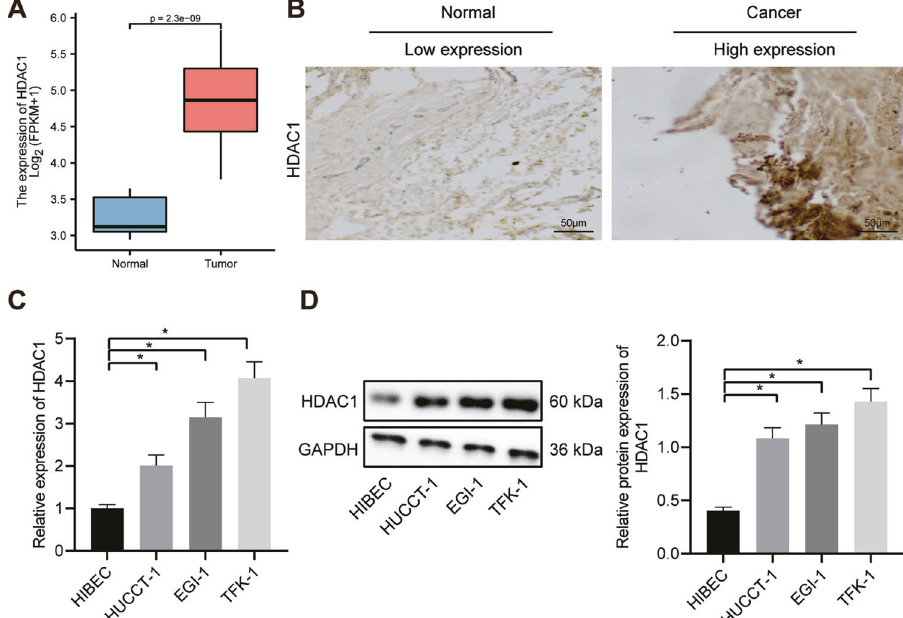
Fig. 1 HDAC1 is upregulated in CC clinical samples and cells. A TCGA database analysis of HDAC1 protein in CC tissues ( n = 36) and control tissues ( n = 9). B The immunohistochemical staining of HDAC1 protein in CC tissues ( n = 65) and normal bile duct tissues ( n = 35). C HDAC1 mRNA expression in TFK-1, HUCCT-1, EGI-1 and HIBEC cell lines determined by RT-qPCR. D, HDAC1 protein expression in TFK-1, HUCCT-1, EGI-1 and HIBEC cell lines measured by Western blot analysis. * p < 0.05. In panels ( A ) and ( B ), data were compared by unpaired t- test. In panels ( C ) and ( D ), data were compared by one-way ANOVA with Tukey ’ s post hoc test. The cell experiment was independently repeated three